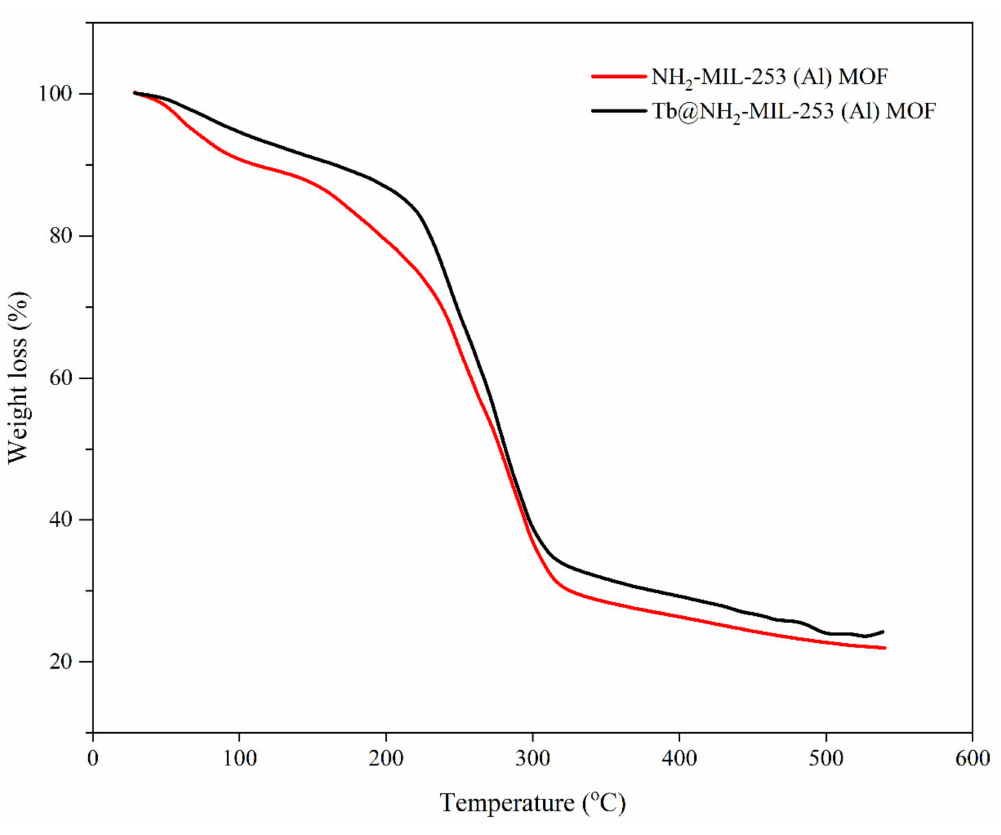
Figure 3. TGA profile of Tb@NH 2 -MIL-253 (Al) MOF, and NH 2 -MIL-253 (Al) MOF fluoresce- nce platforms.